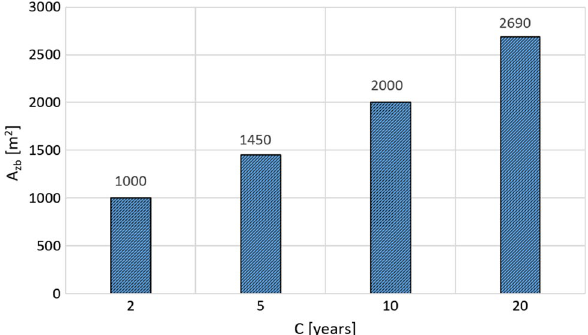
Fig. 10 Required increase in designed storage tank bottom area nec‑ essary to withstand higher values of rainfall recurrence